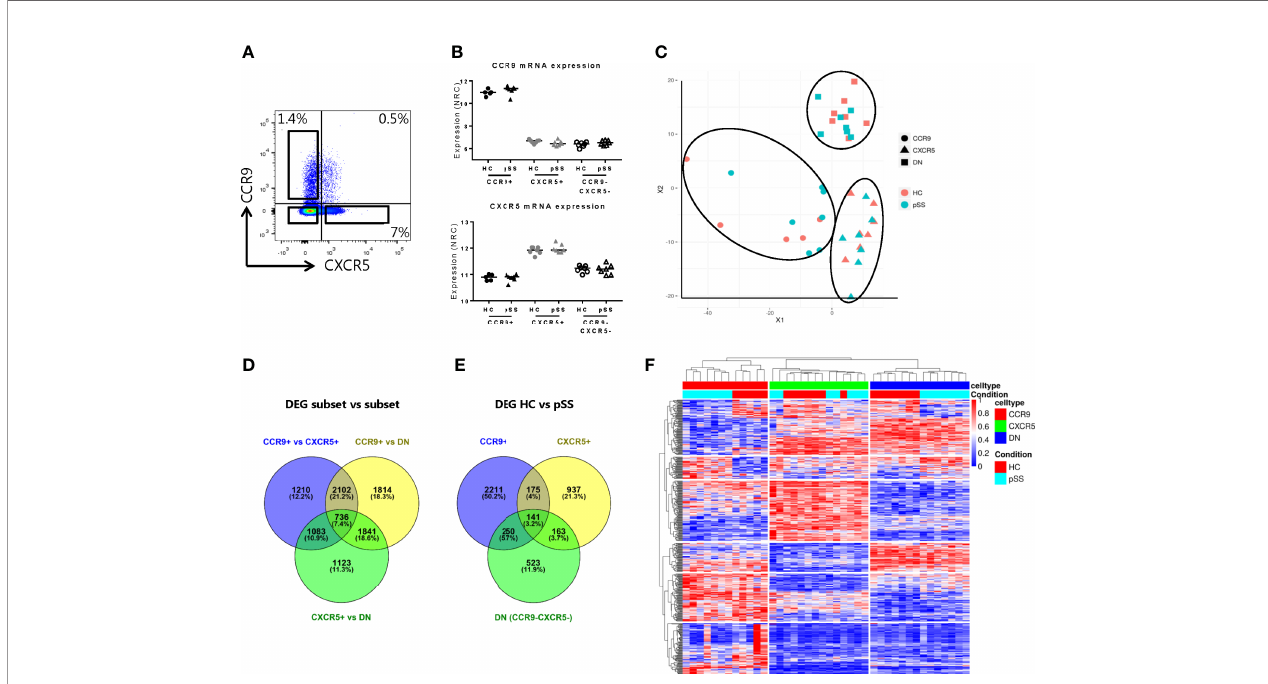
FIGURE 1 | Transcriptomic pro fi ling robustly separates CCR9+, CXCR5+ and CCR9-CXCR5- Th cell subsets and identi fi es differentially expressed genes in pSS patients. RNA sequencing was performed on FACS sorted CCR9+, CXCR5+ and CCR9-CXCR5- (double negative, DN) T helper cells from PBMCs from healthy donors (HC, n=7, CCR9+ subset n=5) and primary Sjögren ’ s syndrome patients (pSS, n=7). Representative fl ow cytometry plot of CCR9 and CXCR5 expression on CD4+ Th cells used for FACS sorting (A) . Con fi rmation of elevated mRNA expression of CCR9 and CXCR5 in the sorted CCR9+ and CXCR5+ Th cells, respectively (B) . NRC: normalized read counts, log2 normalized. Multidimensional scaling plot (MDS) shows all the differentially expressed genes (DEGs) between the Th cell subsets (C) . Venn diagrams show number and percentages of DEGs between the CCR9+ vs CXCR5+ vs DN Th cell subsets (D) and between HC and pSS patients within the CCR9+, CXCR5+ and DN Th cell subsets (E) . Heatmap representation of hierarchical clustering analysis using the top 100 DEGs of all comparisons, shows distinct gene expression pro fi les between the subsets and between HC and pSS patients (F)